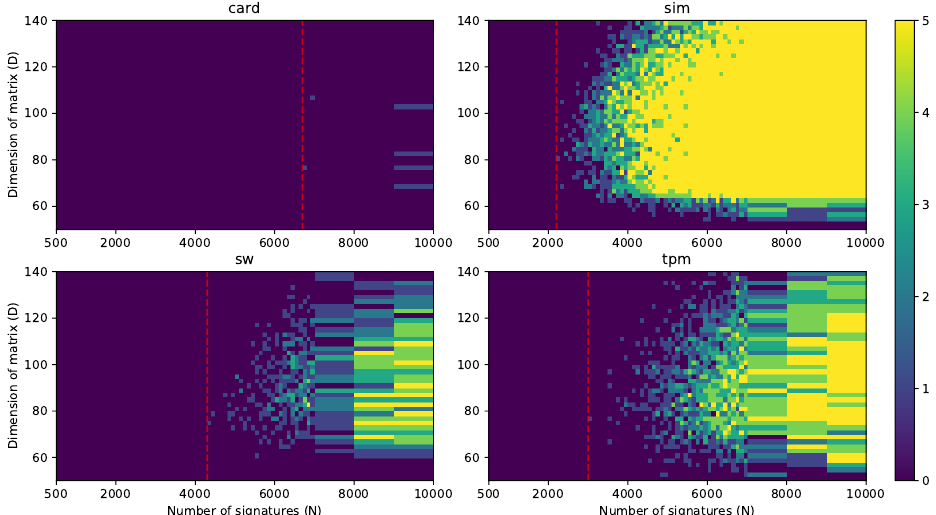
Figure 4: Heatmap of success rate (out of 5 tries) for constant bounds with c = 3.